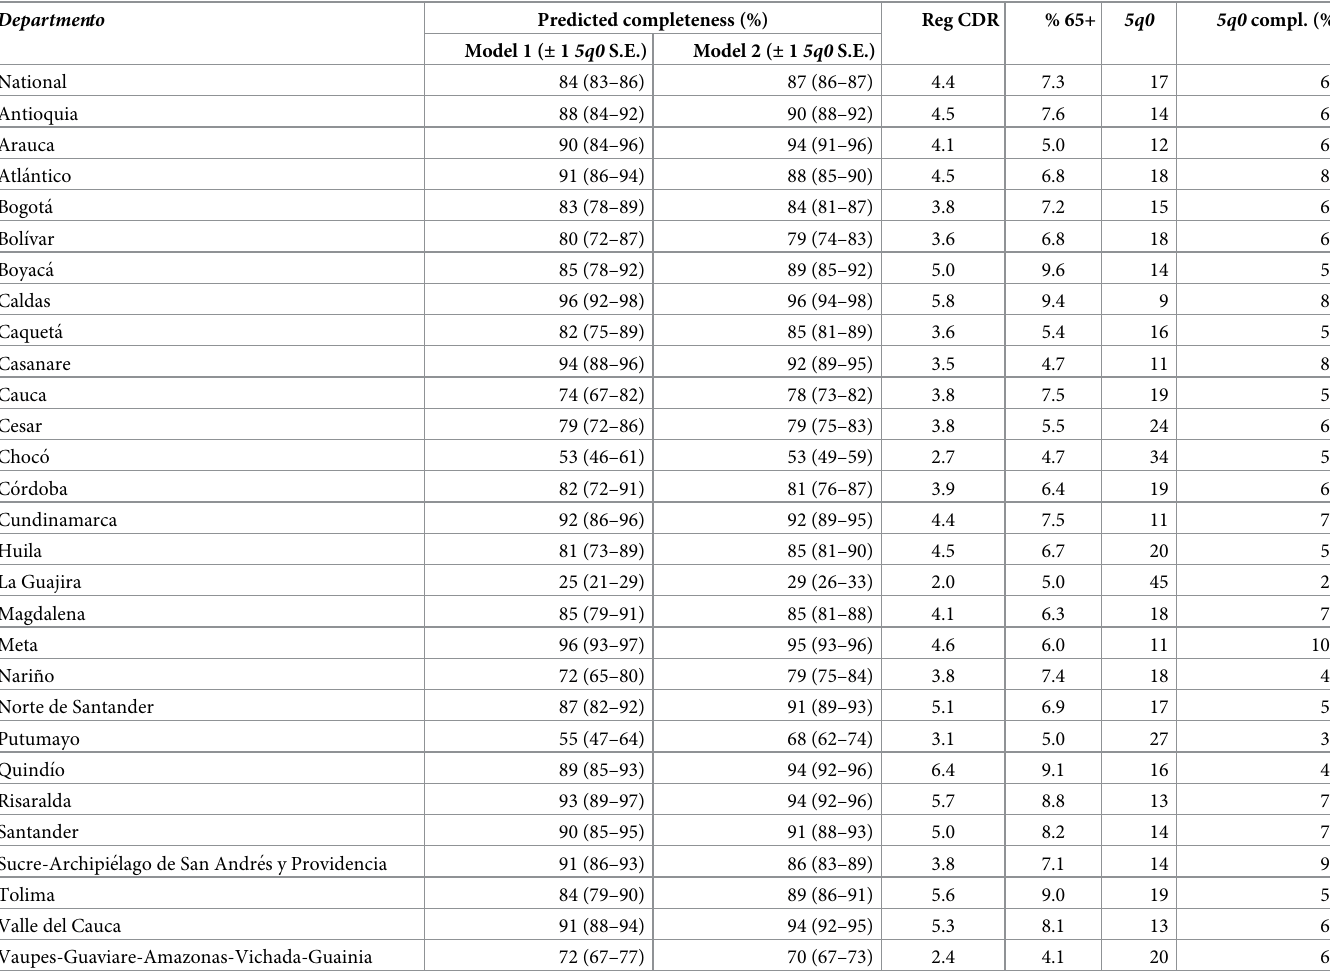
Table 6. Predicted completeness and input data by departmento of residence (%), Colombia, 2014, Models 1 and 2, both